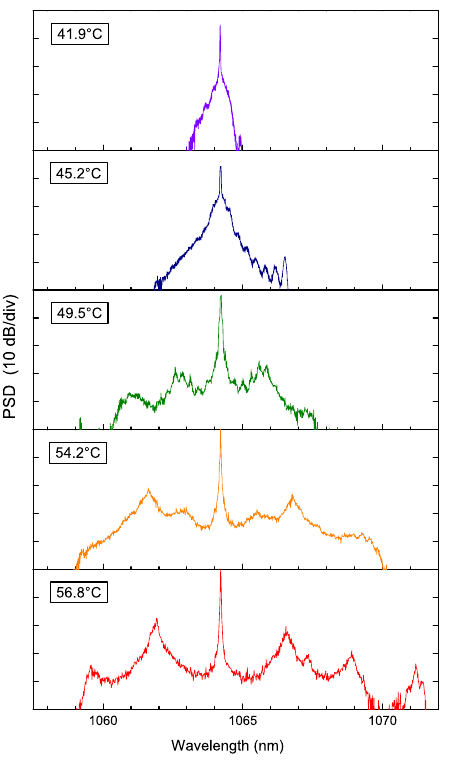
Figure 5: Experimental spectra for phase mismatched SHG. From above to below, the crystal temperature has been progressively in- creased, moving farther from the phase matching condition for the initial SHG. All the spectra have been acquired with the maximum available pump power of 9 W. Power calibration gave an average power per teeth of the order of microwatts.